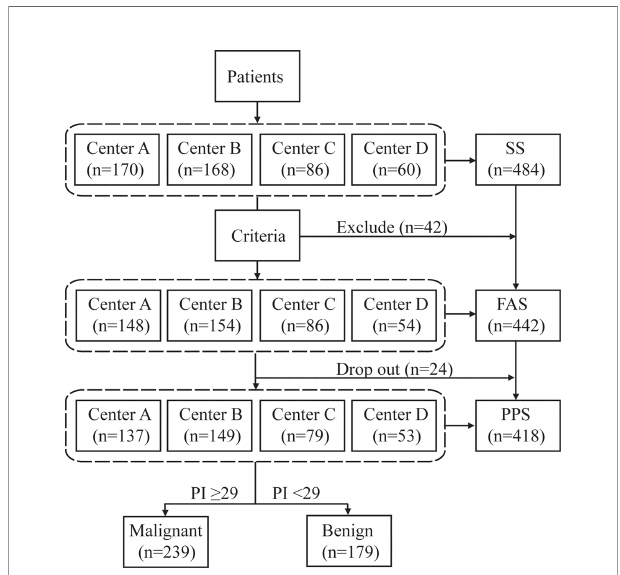
FIGURE 2 | Study design fl ow chart. The safety dataset (SS) was composed of all subjects who underwent EIA and had at least one safety evaluation. The full analysis set (FAS) was made up of all eligible participants who underwent EIA. The per protocol set (PPS) consisted of eligible patients who completed the whole study and excluded severe violations of the protocol. Forty-two patients who were not suitable for the test were excluded, of whom 21 did not have eligible CT, 9 had Algorithm Composite Score < 20, 4 had pulmonary mass >50 mm, 3 had nodules <4 mm, 2 received thoracic intervention therapy, 2 had tuberculosis, 1 had an implanted steel plate in the thorax, one was aged >80 years, 1 had cancer history within fi ve years. Twenty-four patients dropped out of the study, 23 due to the absence of compliance, and one died of cancer progression.